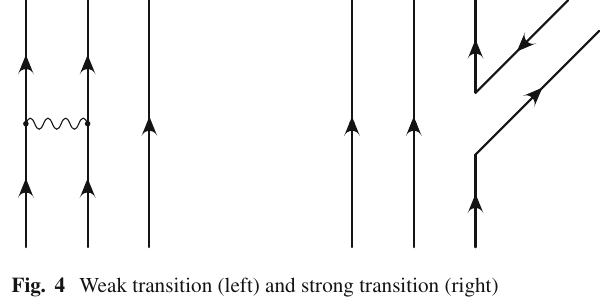
Fig. 4 Weak transition (left) and strong transition (right)